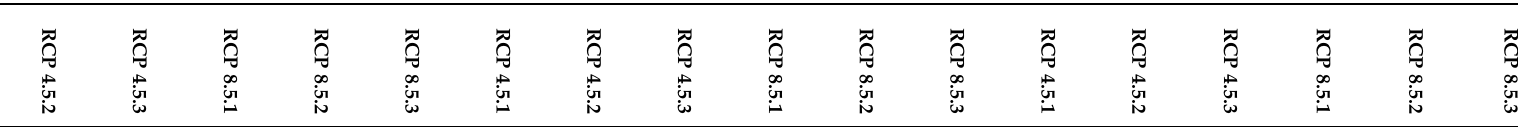
Table 7. Comparison of the average temperature distribution in individual months for the SWAT simulation period 2010–2017 with individual projections for